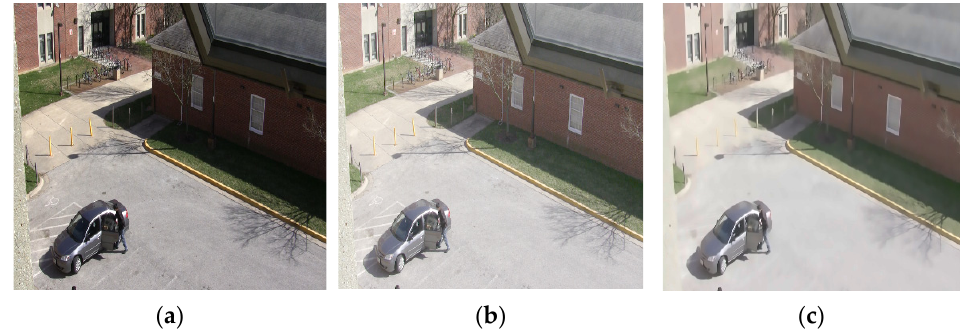
Figure 2. Pre-processing results on the VIRAT dataset, including ( a ) original image, ( b ) intensity- adjusted image, and ( c ) smooth image.